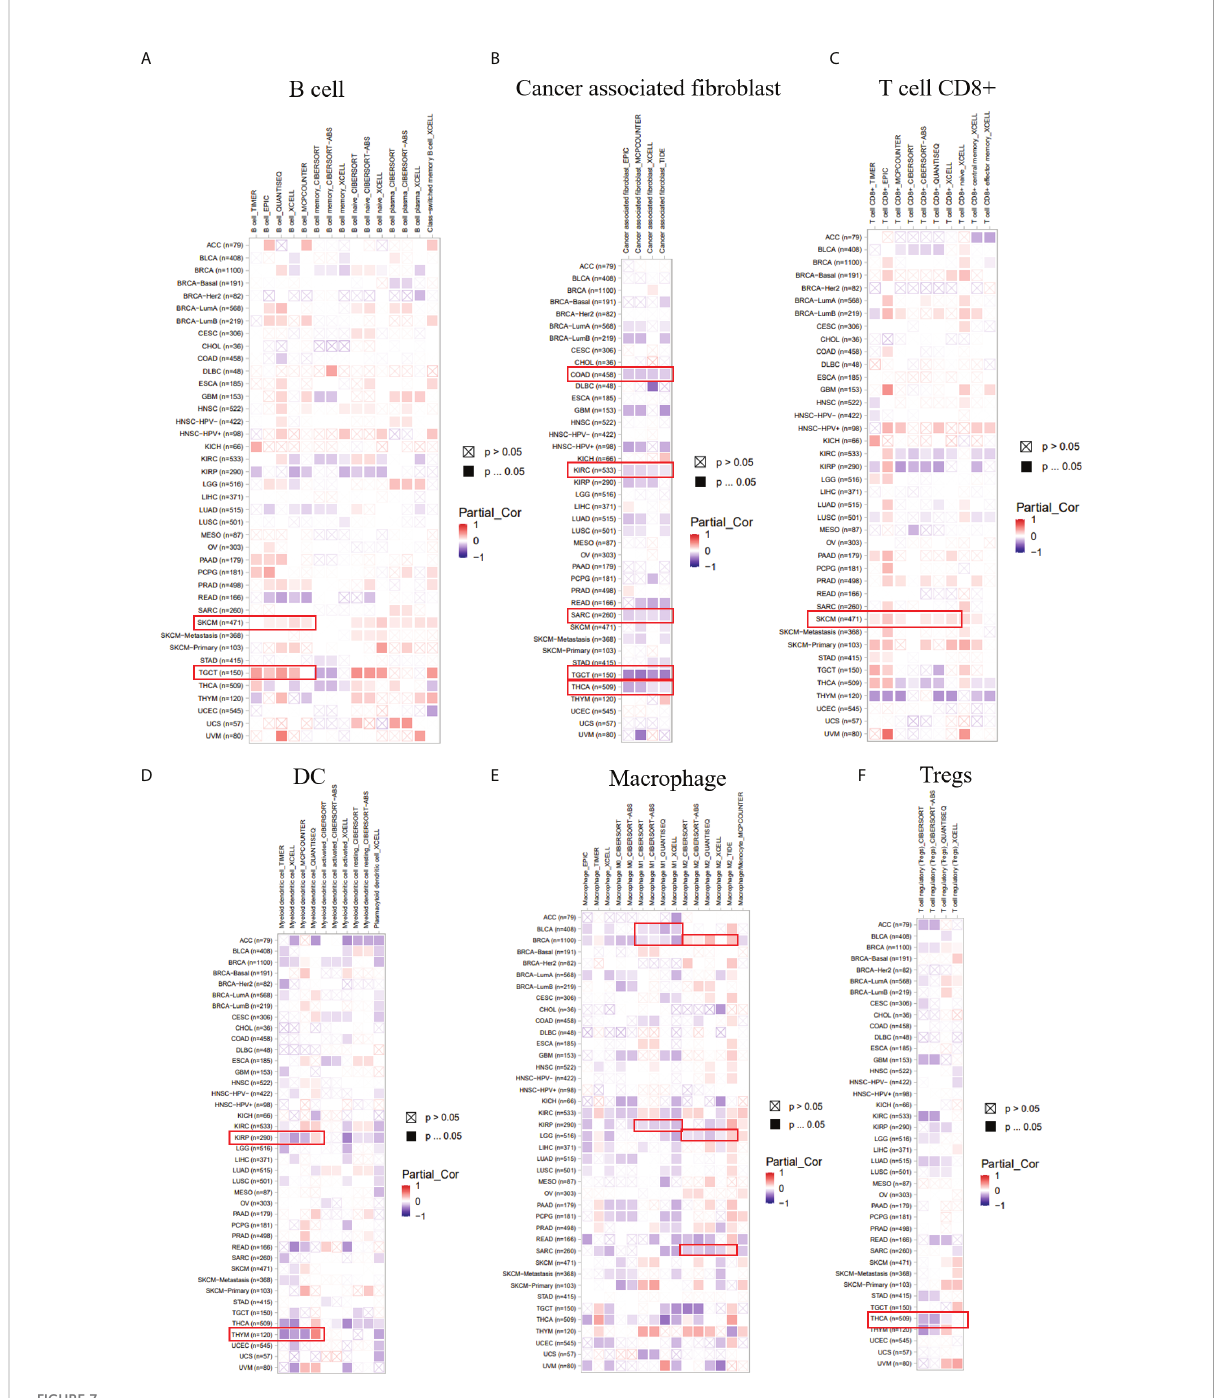
FIGURE 7 The correlation between the LIAS expression and several immune cells. (A – F) The TIMER2.0 database depicted the relationship between LIAS expression and immune in fi ltration of B cell (A) , cancer-associated fi broblast (B) , T cell CD8+ (C) , DC (D) , macrophage (E) , and Tregs (F) through several